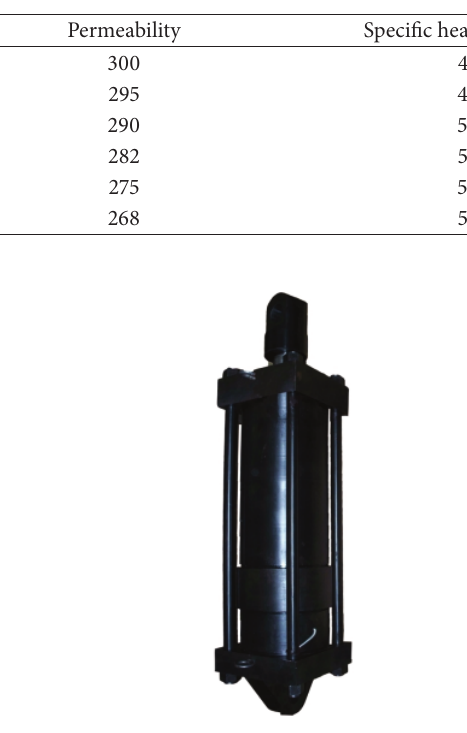
Table 1: Temperature properties of 45# steel.